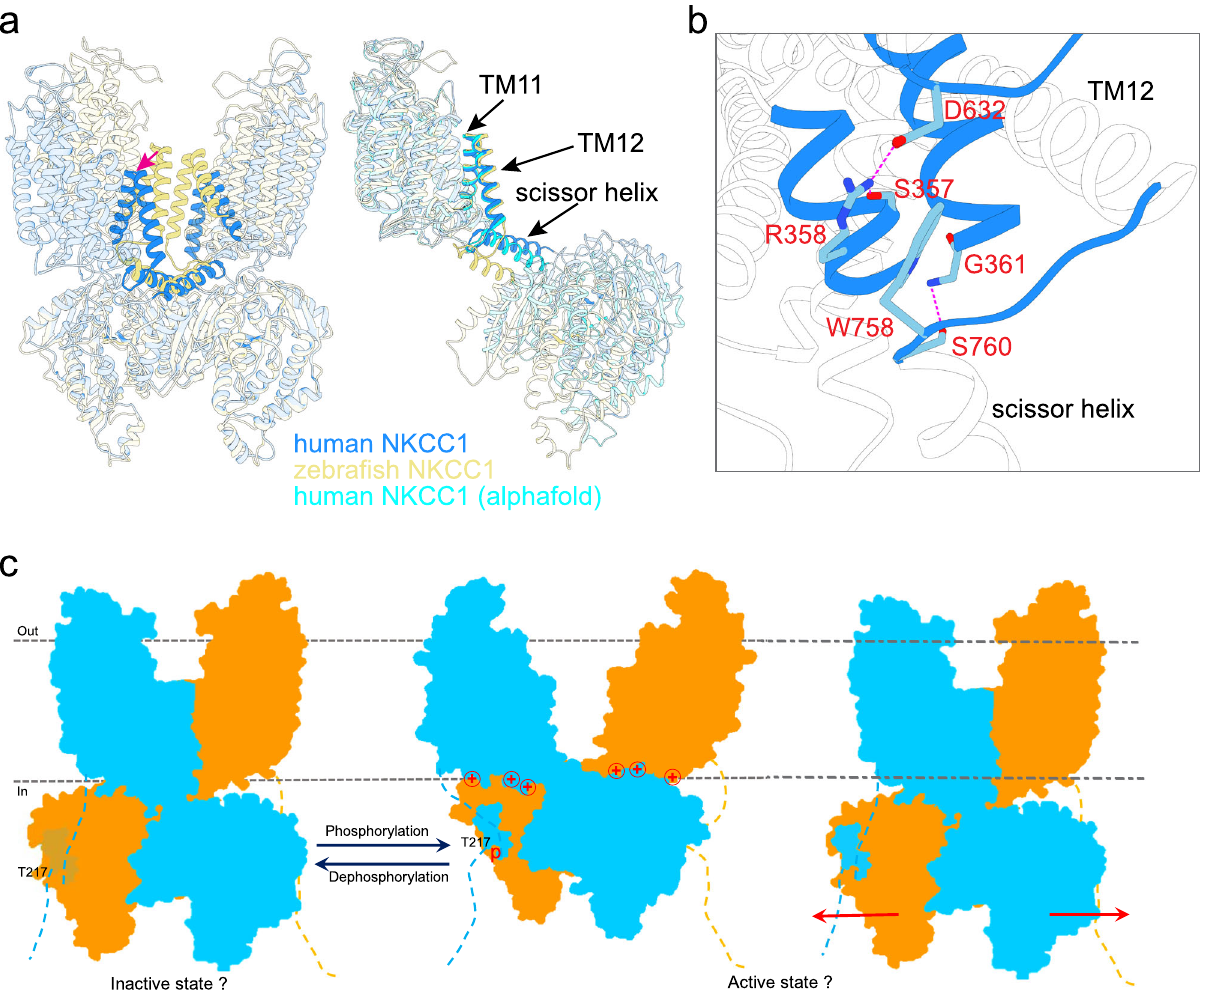
Fig. 5 NKCC1 iii /bumetanide adopts a dimeric architecture. a Left, superimposition of human and zebra fi sh NKCC1 dimers based on their C-terminal domains shows that the two transmembrane units in human NKCC1 separate and interact extensively with its C-terminal domains. Right, superimposition of a single human and zebra fi sh NKCC1 subunit based on their transmembrane domains shows displacement of the scissor helix and C-terminal domain as the loop that connects the TM12 and scissor helices assumes different conformations in these structures. b In the NKCC1 iii /bumetanide structure, the loop connecting the TM12 and scissor helices is stabilized by interactions with the transmembrane unit. Hydrophilic interactions are depicted as dashed lines. c A hypothetical model depicts NKCC1 regulation by (de)phosphorylation. Kinases and phosphatases possibly oppositely tune the strength of association between the cytosolic N- and C-terminal domains with weak and strong association indicted by faded and bright N-terminal regulatory segment, respectively. It remains uncertain whether phosphorylation leads to disengagement of the two transmembrane units or triggers dissociation of the two interdigitating C-terminal domains as indicated by the two oppositely directed red